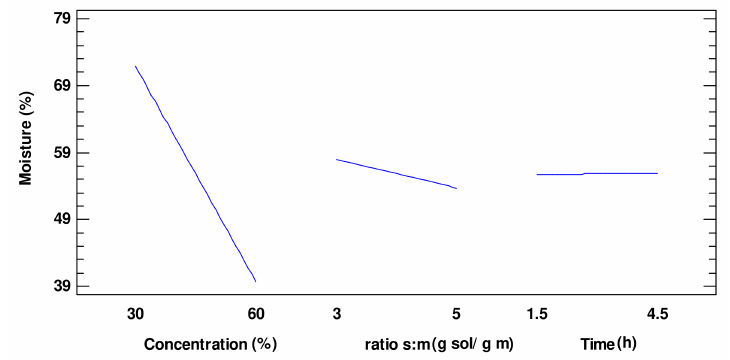
Figure 6. Plot of main effects.